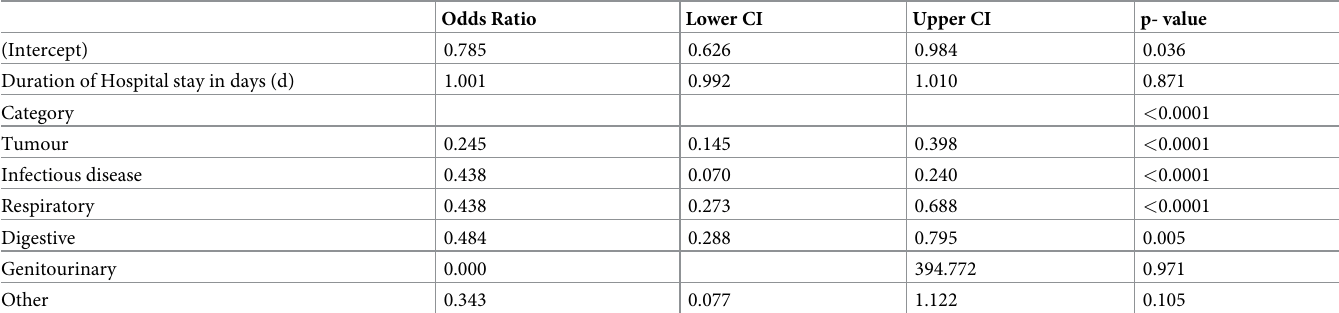
Table 4. Binary logistic regression with discrepancy as a dependent variable.